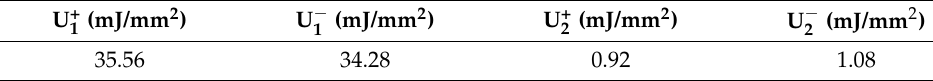
Table 3. The Hashin damage evolution parameters of the